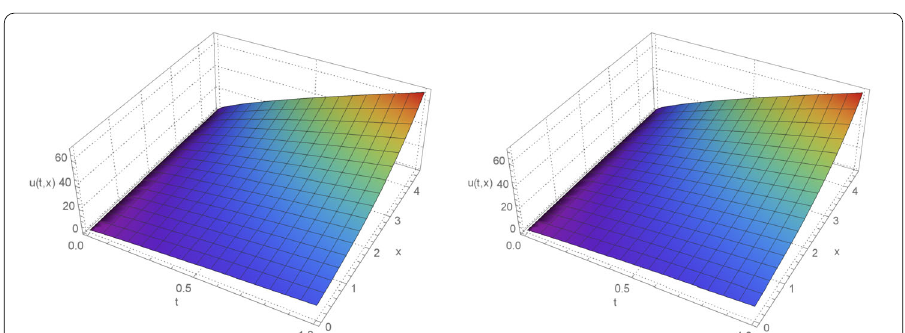
Figure 6 RPSM vs. q-HAM for Case II for U (2) ( t , x ) with β = 0.1, γ = 0.1 and α = 0.45